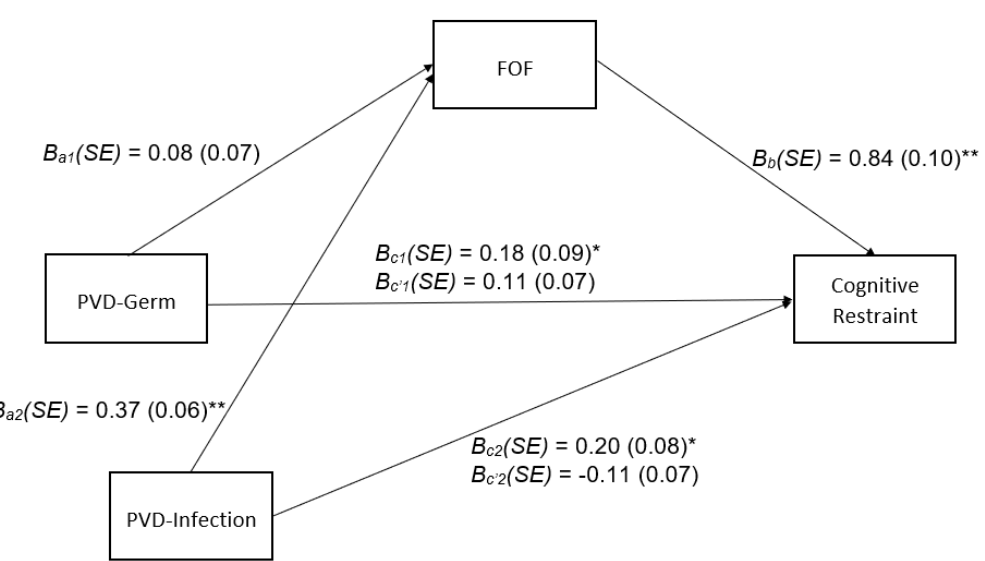
Figure A1. Sex — Stratified Analyses for PVD Subscales, FOF, and Cognitive Restraint. Process Model — 4 path estimates from sex-stratified analyses testing the indirect effect of perceived germ aversion and perceived infectability on cognitive restraint through fear of fat. Unstandardized coefficients and standard errors are presented (* p < 0.05, ** p < 0.01). Indirect effect of PVD-Germ path for male, B (SE) = − 0.02 (0.05), 95% CI [ − 0.11, 0.75], and female, B (SE) = 0.07 (0.06), 95% CI [ − 0.03, 0.19], participants. Indirect effect of PVD-Infection path for male, B (SE) = 0.22 (0.05), 95% CI [0.12, 0.34], and female, B (SE) = 0.31 (0.06), 95% CI [0.21, 0.45], participants.